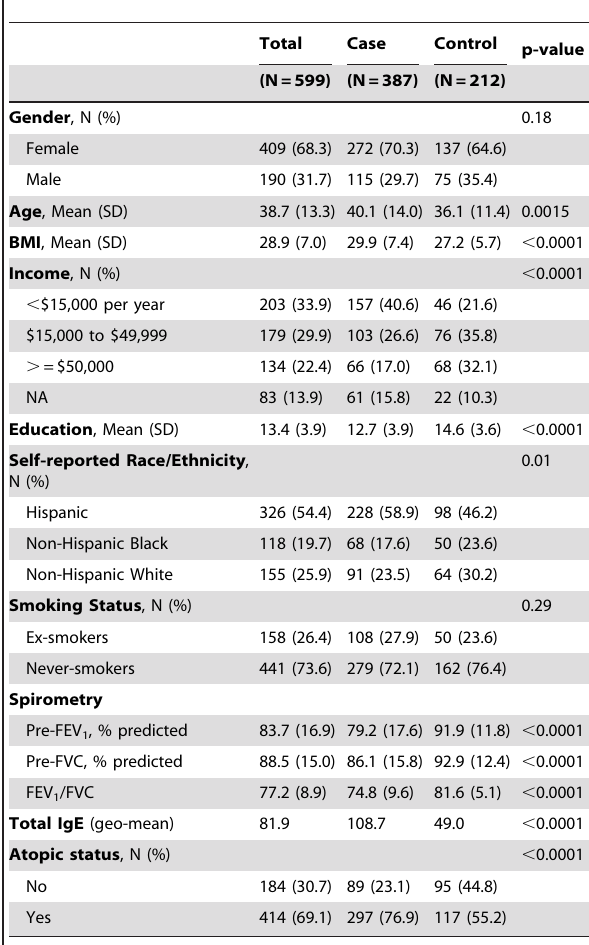
Table 1. Characteristics of NYUBAR case-control